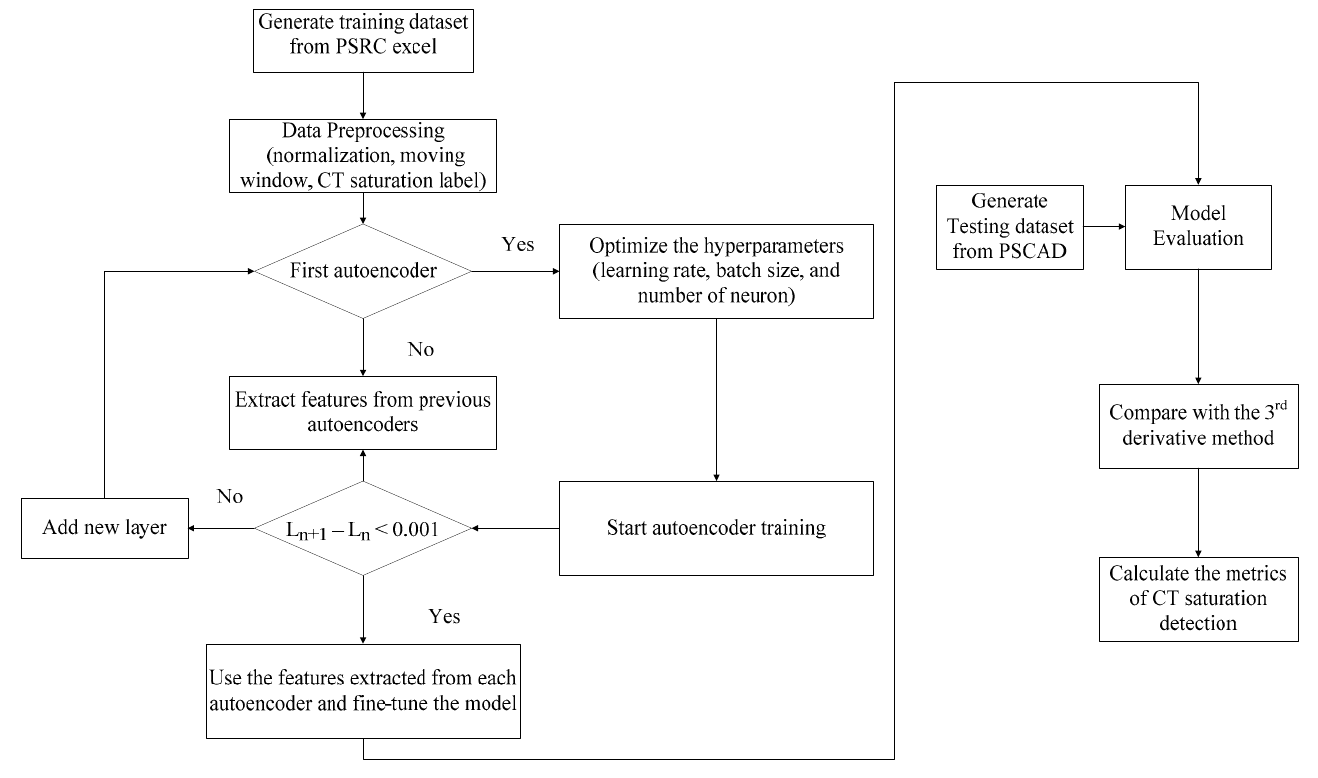
Figure 4. Framework of the proposed DNN based method for CT saturation detection .